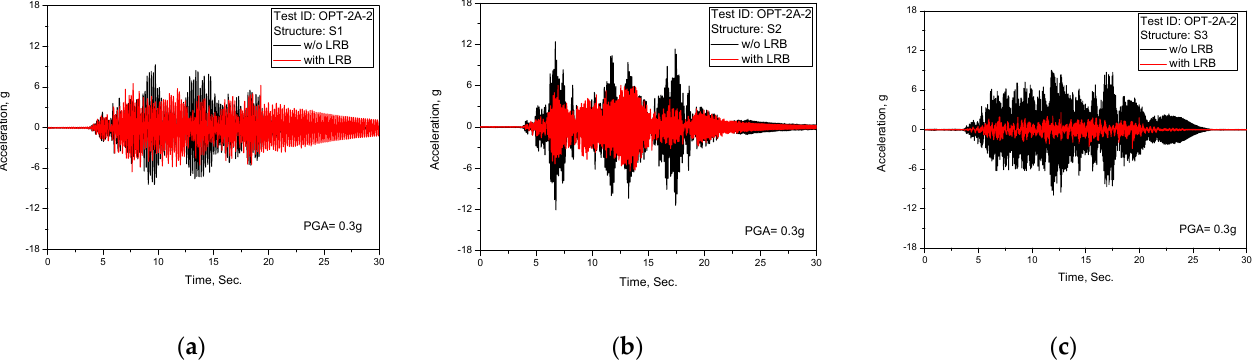
Figure 7. Test results of acceleration time history response (TEST ID: OPT-2A-2, PGA = 0.3 g): ( a ) S1; ( b ) S2; ( c ) S3.